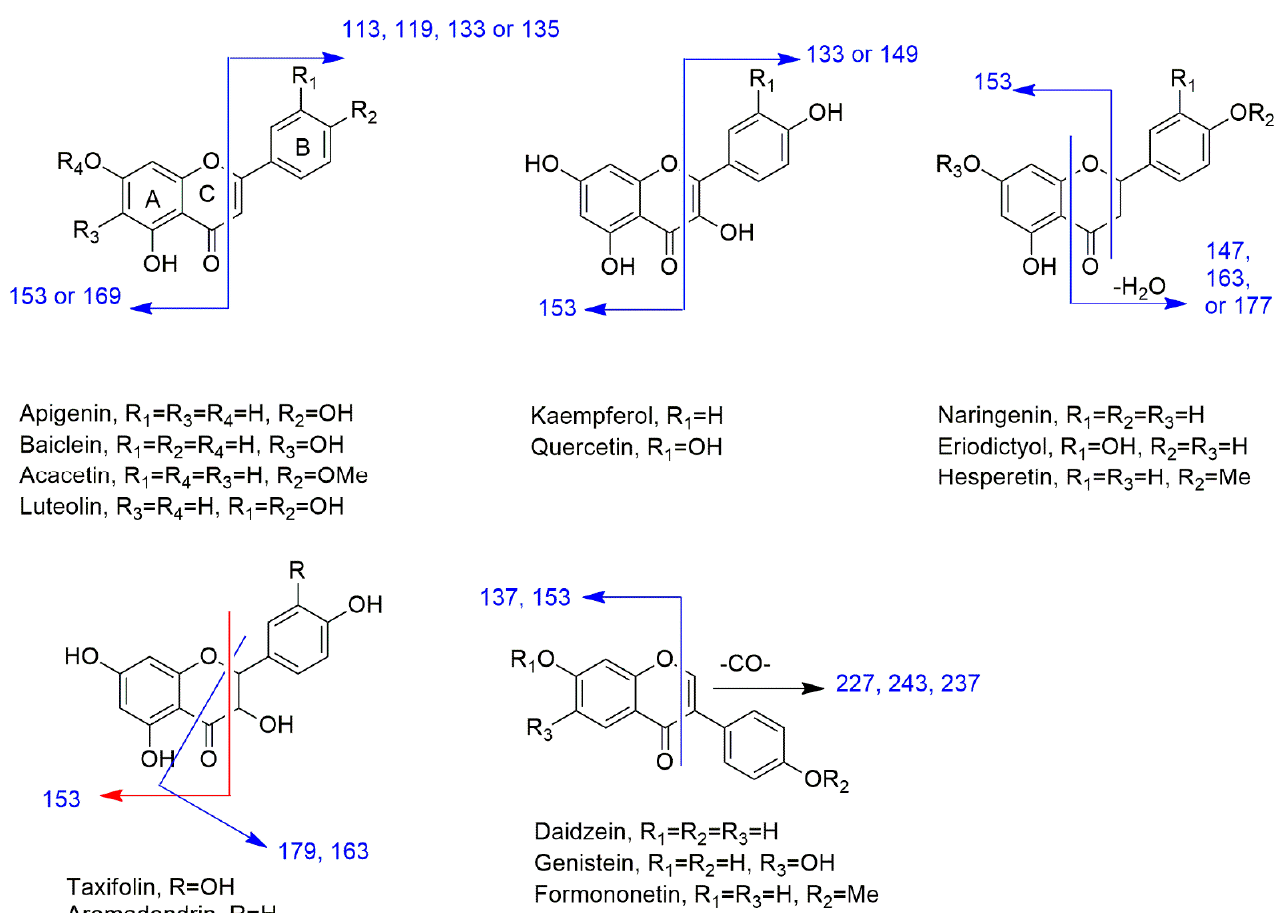
Figure 1. The structures and fragmentation pattern in positive ion mode for the identified aglycones. Flavone Subclass Luteolin, apigenin, acacetin, and baicalein aglycones and glycosides were confirmed by the corresponding base peak and the fragmentation pattern for each compound. In positive ion mode analysis, the MS/MS fragment at m/z 153 is characteristic for 5, 7-dihy- droxy flavonoids which were detected in luteolin, apigenin, and acacetin. This fragment is increased by 16 D for baicalein due to the hydroxylation at C6. While the MS/MS frag- ment at m/z 135 for 3 ′ ,4 ′ -dihydroxy flavones is indicative for luteolin. The latter fragment is replaced by the fragment at m/z 119, 133, and 113 for apigenin, acacetin, and baicalein, respectively due to the fragment ion of ring B with a free hydroxyl group, O -methylation or without hydroxylation at C4 ′ position.